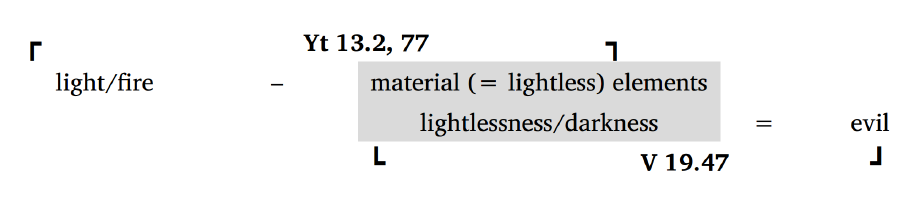
Figure 1 Scheme of superimposition of two (explicit or implicit) Avestan